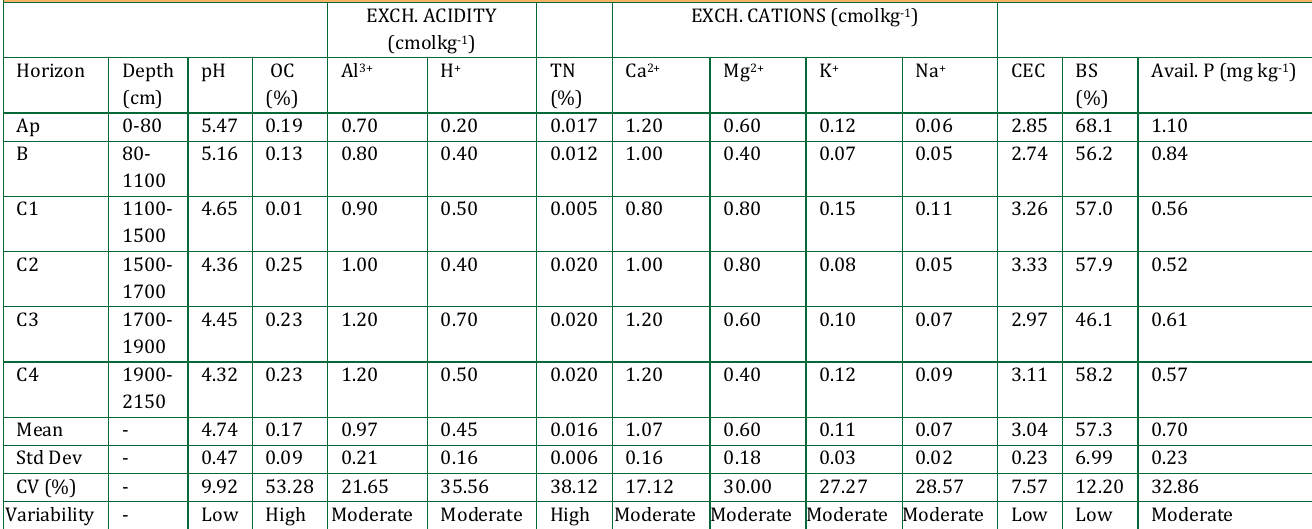
Table 4: Some chemical properties of the Horizons within the profile pit at the excavation site EXCH. ACIDITY